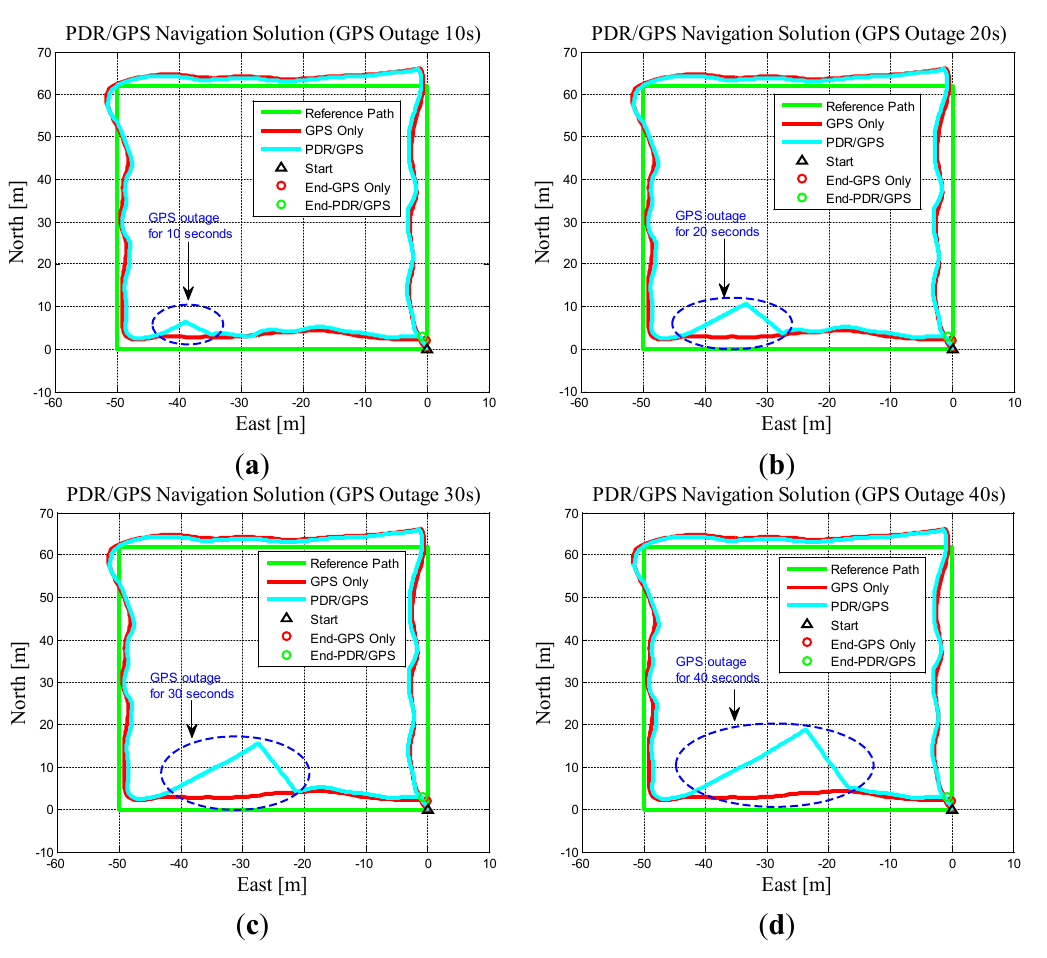
Figure 5. PDR/GNSS system’s navigation solutions for simulated different GPS Outages of ( a ) 10 s; ( b ) 20 s; ( c ) 30 s; ( d ) 40